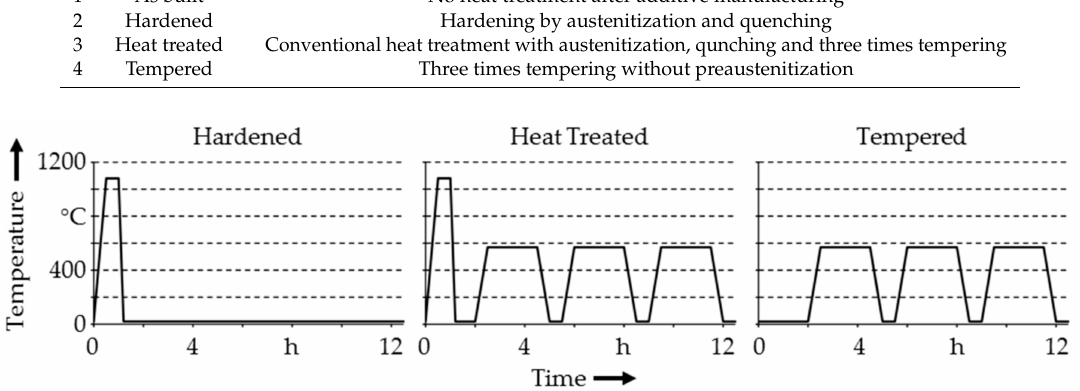
Figure 3. Temperature-Time cycles of the conducted heat